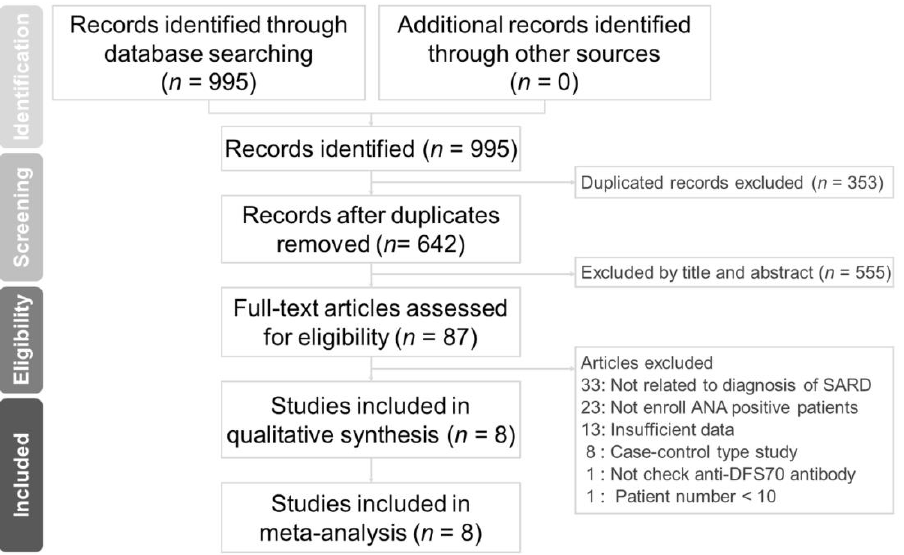
Figure 1. Flowchart of the study selection for the current meta-analysis.